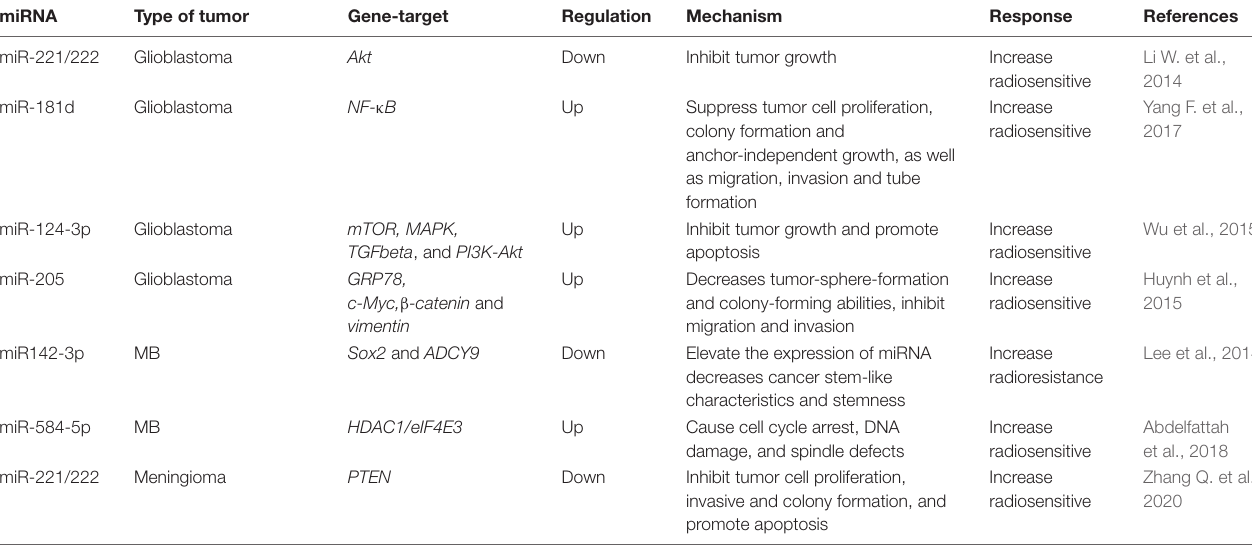
TABLE 3 | Role miRNAs in regulating malignant primary brain tumors (MPBTs) radiosensitivity.